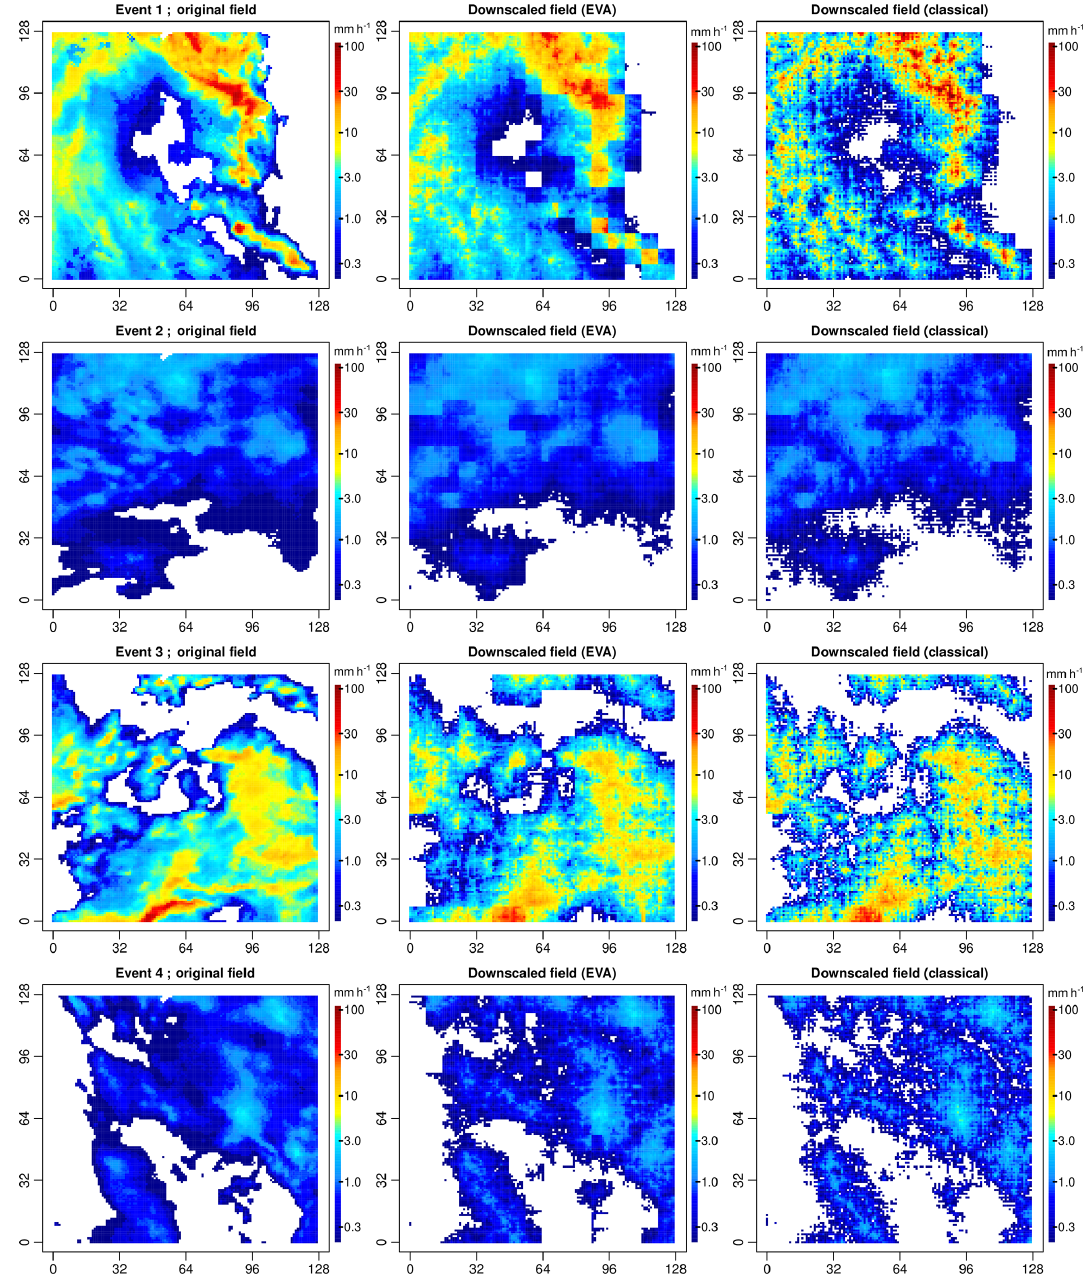
Figure 10. Downscaled rainfall fields for events 1–4 and a downscaling factor of 64 (i.e., input resolution of 8km × 8km and target resolution of 1km × 1km). The left column shows the original radar rainfall snapshots at 1km × 1km. The middle and right columns show the outputs of the EVA and classical cascade models for the (biased) coarse-scale sample generator. Only the first of 100 different random realizations for each field and cascade model is